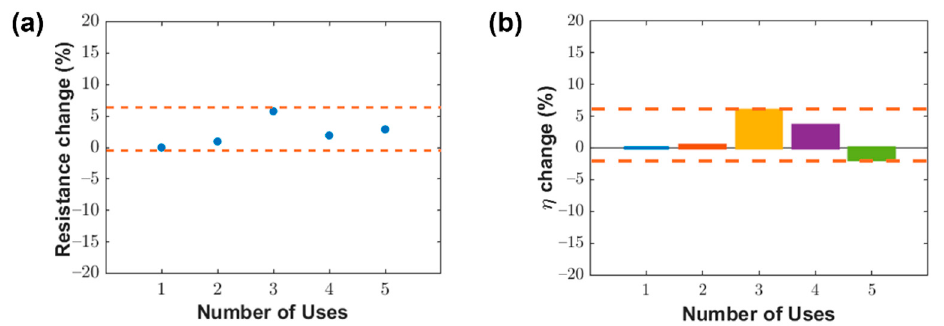
Figure 7. ( a ) Electrical resistance changes with repeated washing for DF-dLIG filter. ( b ) PM 2.5 removal performance changes with repeated washing for DF-dLIG filter.